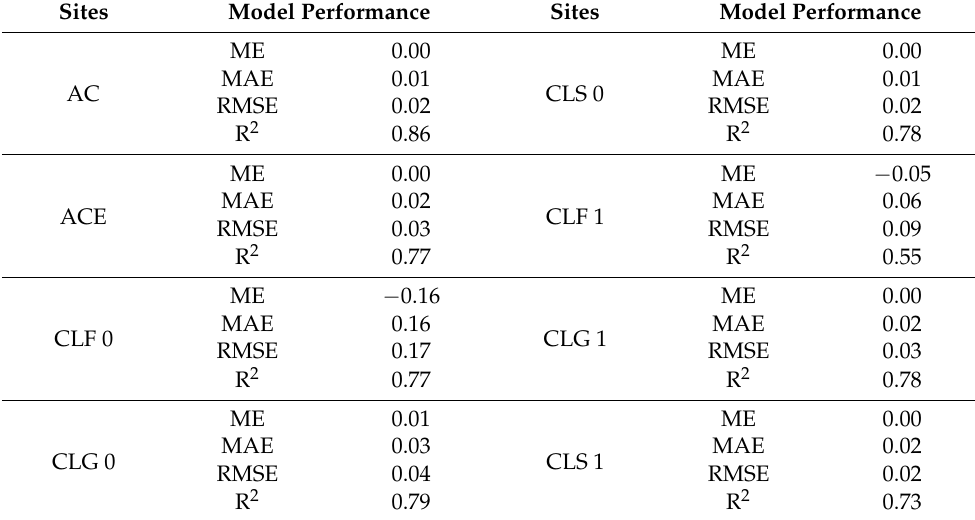
Table 3. Level of agreement between measured and simulated SM